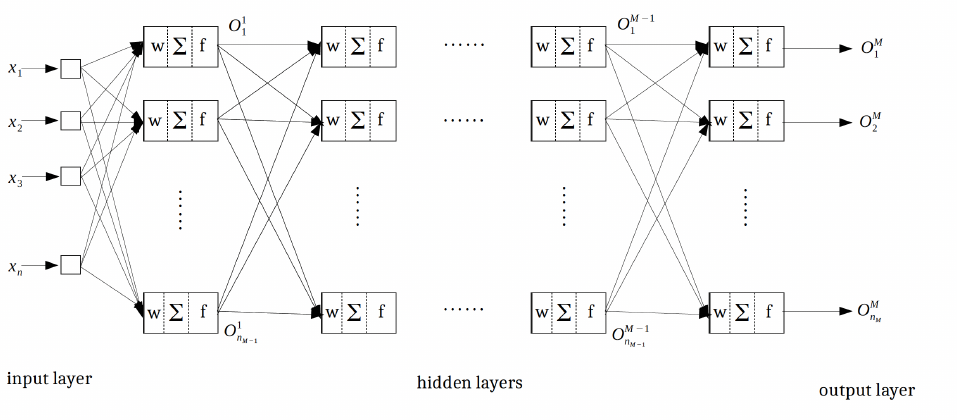
Figure 3. The structure of multilayer feed-forward neural networks